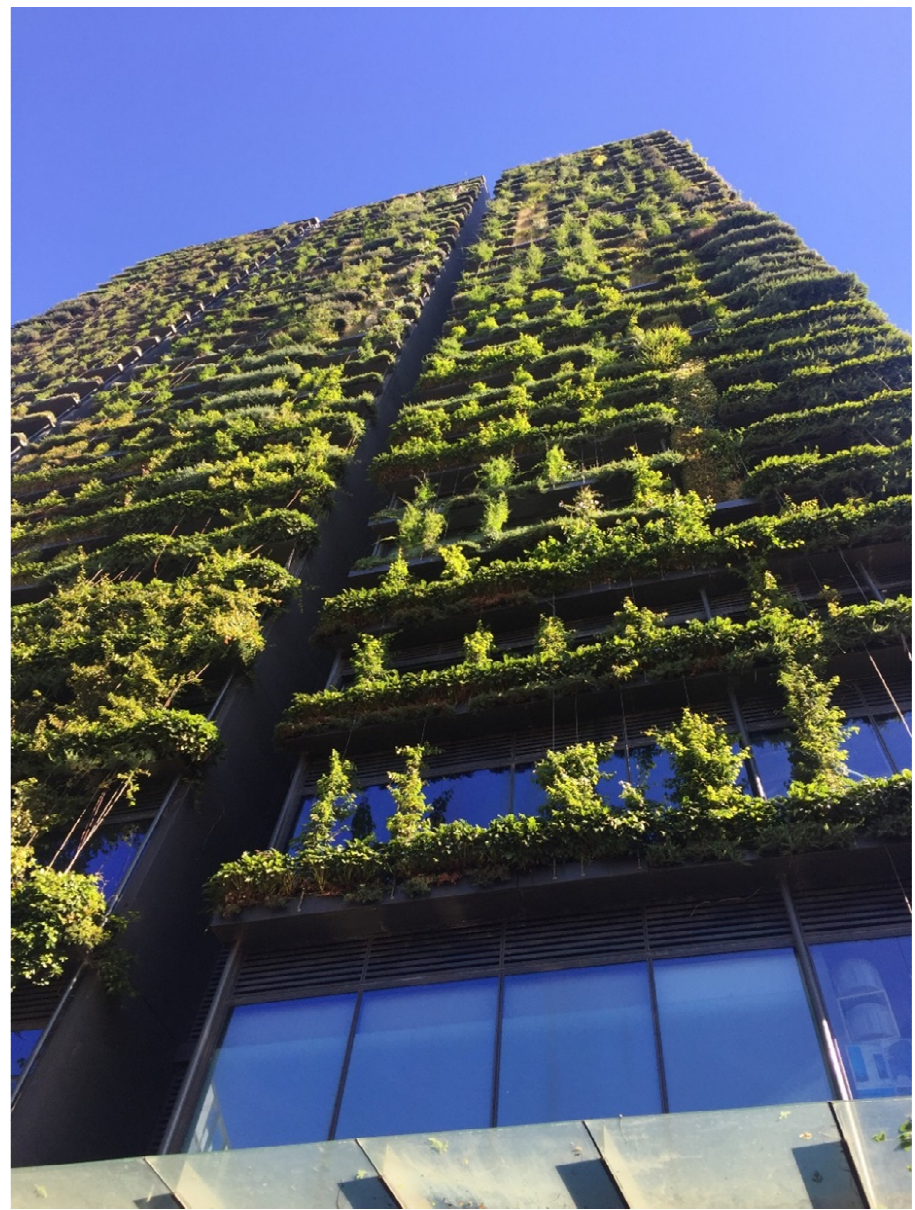
Figure 1. Sydney’s Largest Living Wall at One Central Park.